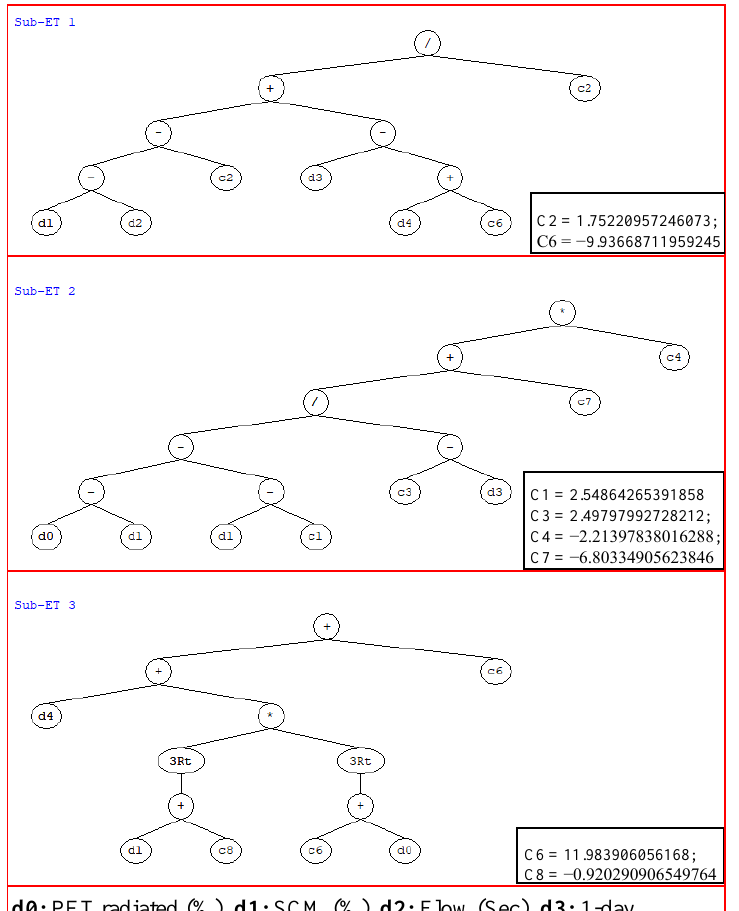
Figure 5. GEP tree obtained from GeneX pro tool for the most optimal case (Trial 5) for determining simple mathematical expression of compression strength of waste PET/SCM blended cementitious grout .